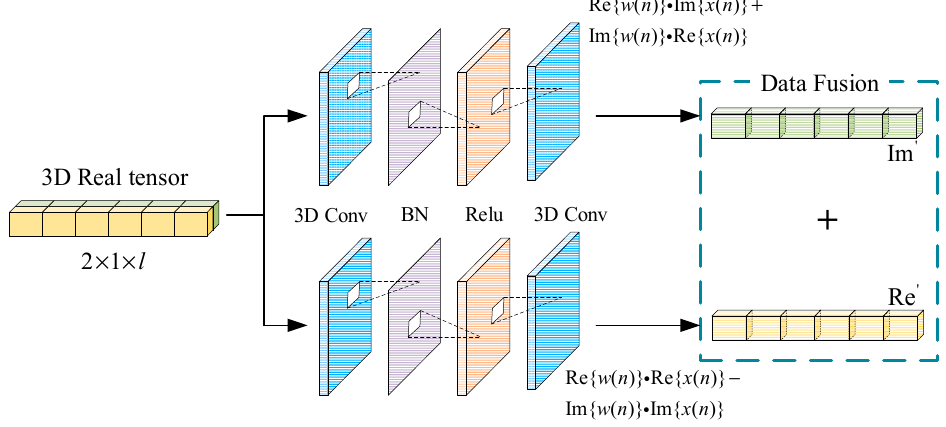
Figure 3. Feature extraction module.